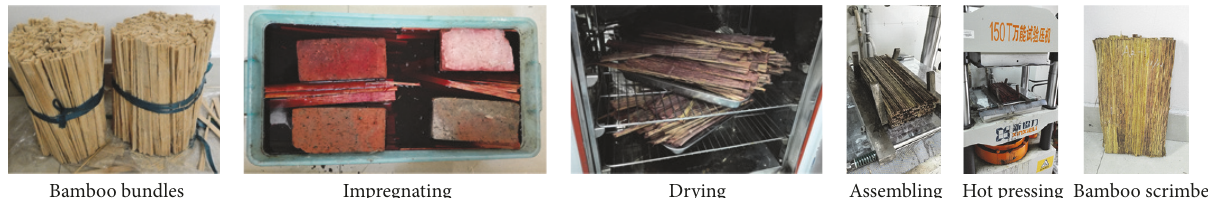
Figure 1: General manufacturing process of bamboo scrimbers in the laboratory.